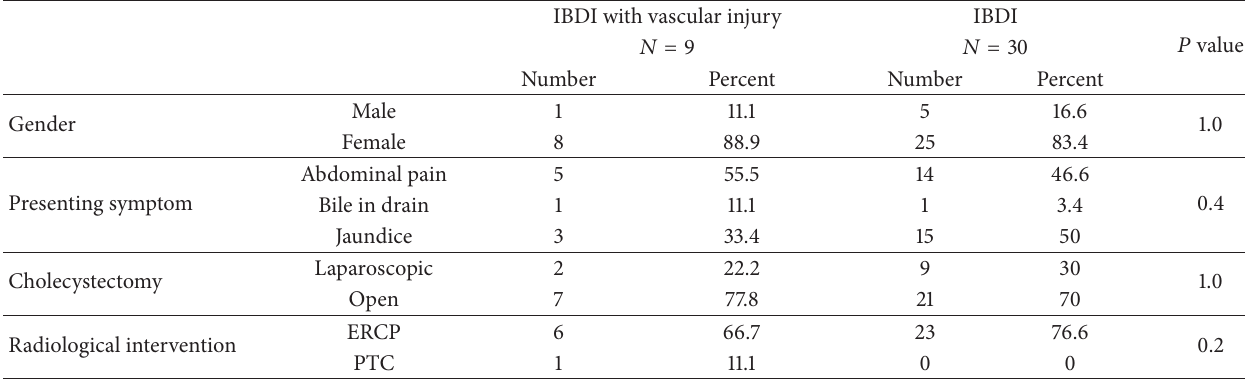
Table 1: Patient characteristics.